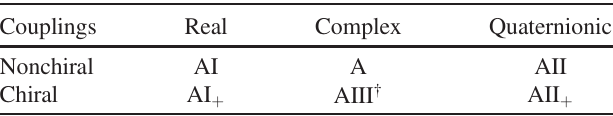
TABLE VIII. Symmetry classes realized in complex-fermion nHSYK and nHWSYK